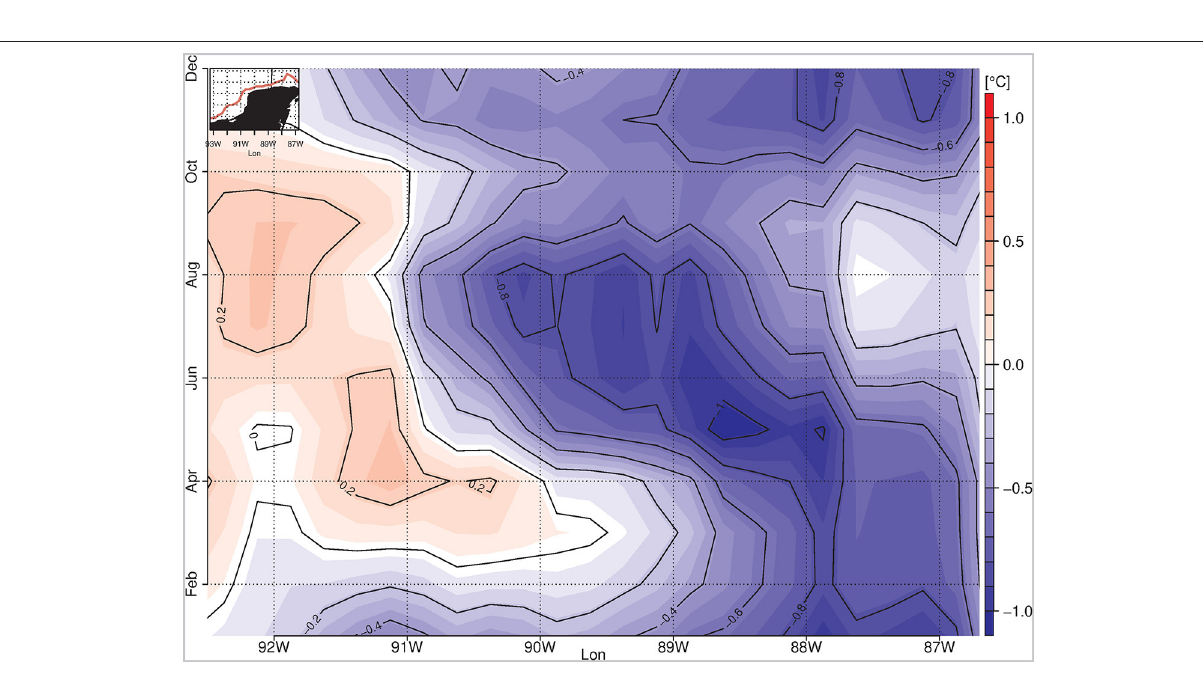
Frontiers in Marine Science |